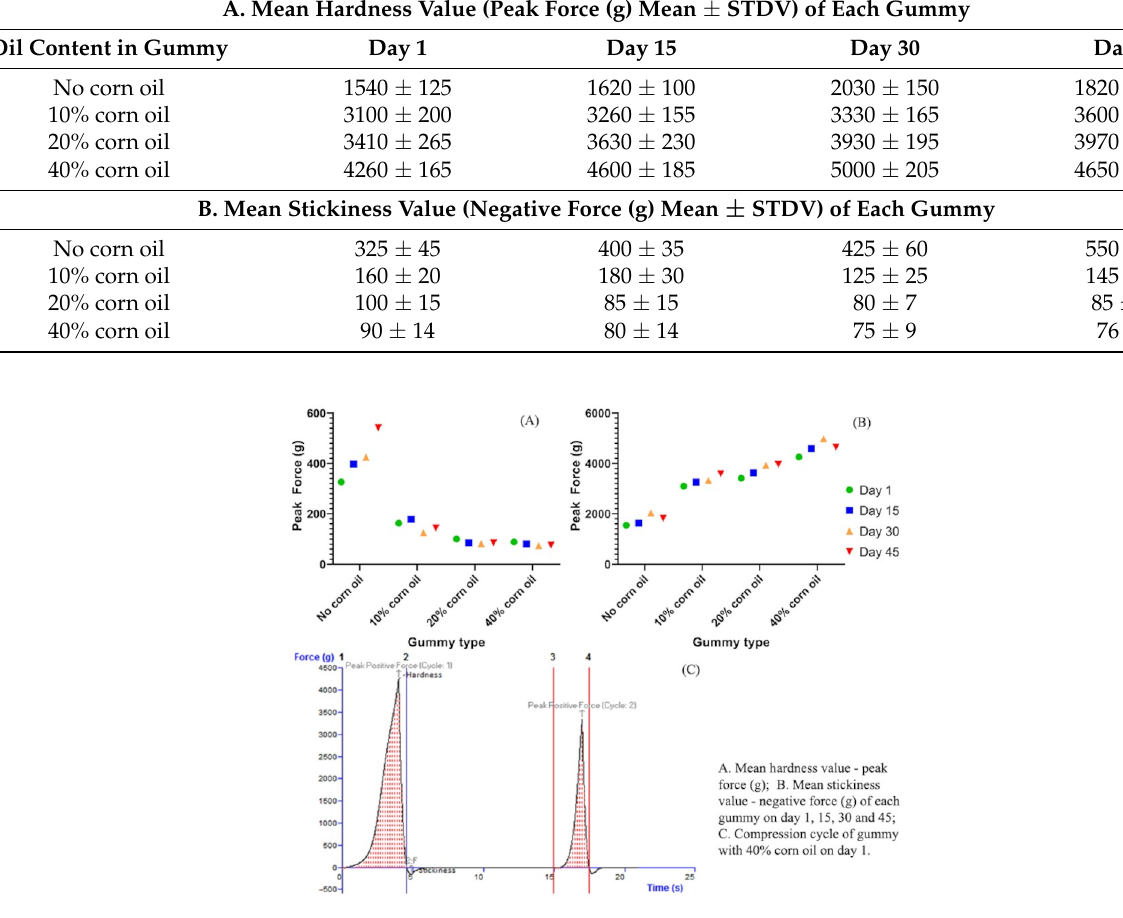
Figure 6. Graphical representation of ( A ) peak hardness cum ( B ) peak stickiness of each gummy on day 1, 15, 30 and 45 and ( C ) force-time curve of 40% corn oil gummy on day